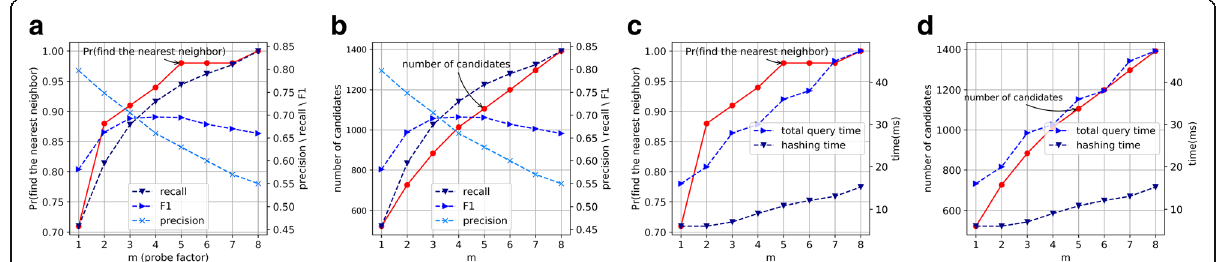
Fig. 4 The effect of the probe factor m on the algorithm. a m versus the probability of find the nearest neighbor and precision/recall/F1. b m versus the number of candidates and precision/recall/F1. c m versus the probability of find the nearest neighbor and query/hashing time. d m versus the number of candidates and query/hashing time